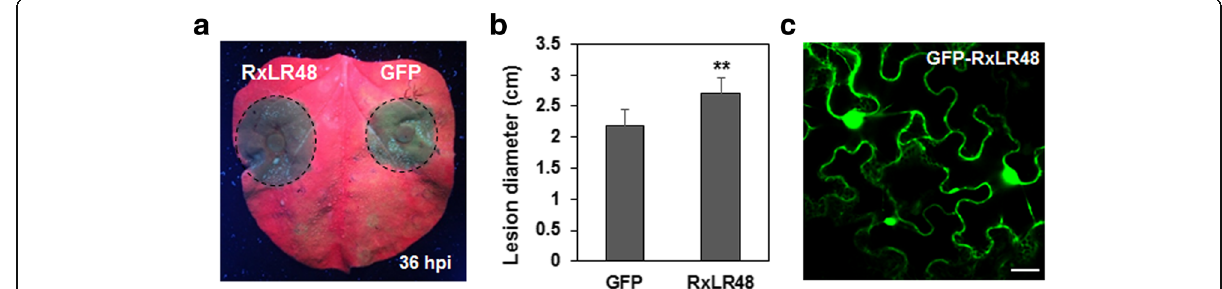
Fig. 2 RxLR48 facilitates Phytophthora capsici infection in Nicotiana benthamiana. a, b Enhanced infection of P. capsici by RxLR48. Equal area of mycelium was inoculated onto leaf regions transiently expressing RxLR48 or GFP at 36 hpi. Photographs ( a ) were taken under UV light and lesion diameters were measured at 36 hpi. The shown data ( b ) calculated from three independent biological replicates, and error bars represent + SD of at least six leaves each (**, P < 0.01, Student ’ s t test). c Expression of RxLR48 in planta . Expression of RxLR48 was visualized by confocal images of N. benthamiana epidermal cells. Photographs were taken at 48 hpi. White scale bar represents 20 μ